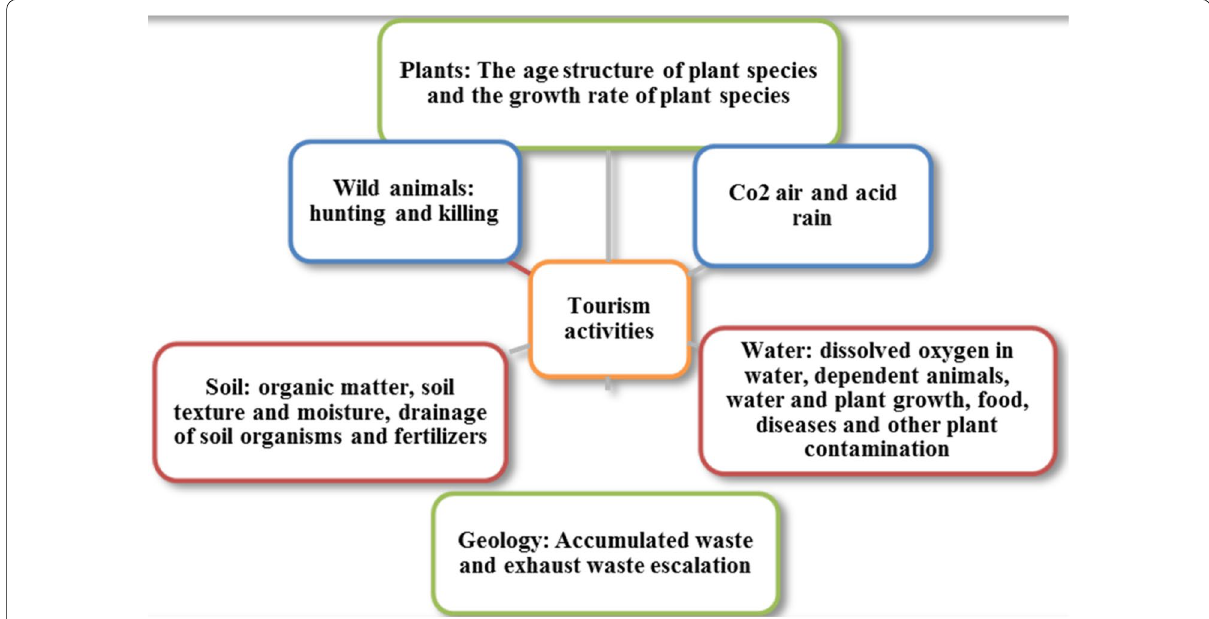
Fig. 3 Multilateral effects of tourism